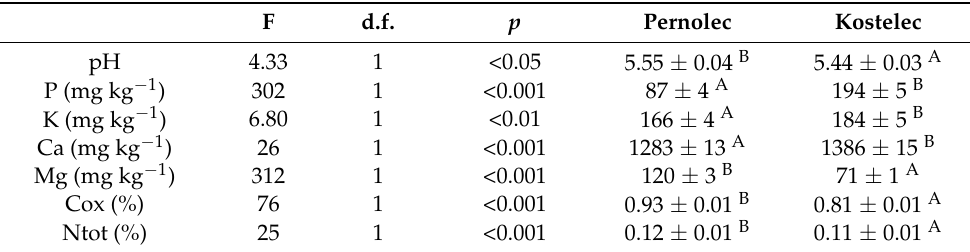
Mean values ( ± SE) followed by the same letter (a vertical comparison of the effect of fertilizer treatment) are not statistically significantly different. Columns without letters (P, Mg, Cox, Nt) represent values without statistically significant differences, where the effect of fertilizer treatments was insignificant. Table 6. Average values of soil parameters in Pernolec and Kostelec. The values are based on the results of soil analyses of all fertilization treatments and all analyzed years